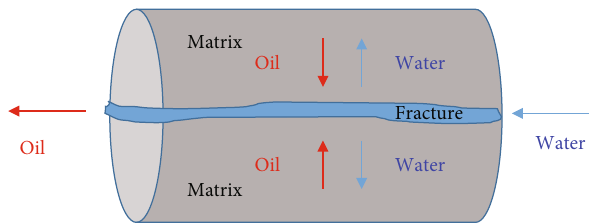
Figure 1: Diagram of oil and water exchange between fracture and